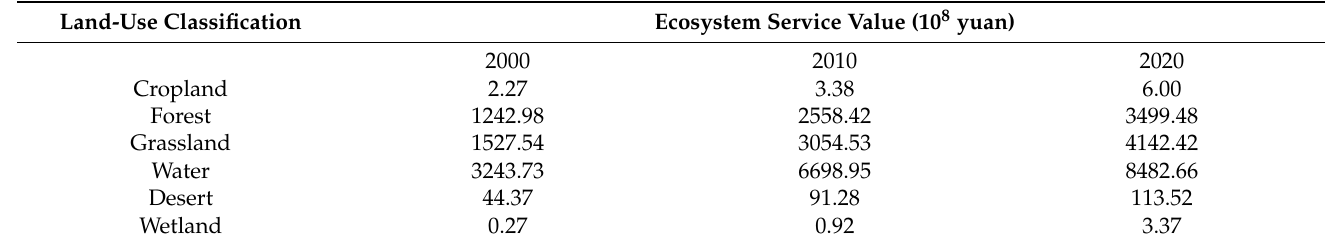
Table 4. ESV of various land use in the Yarlung Zangbo river basin from 2000 to